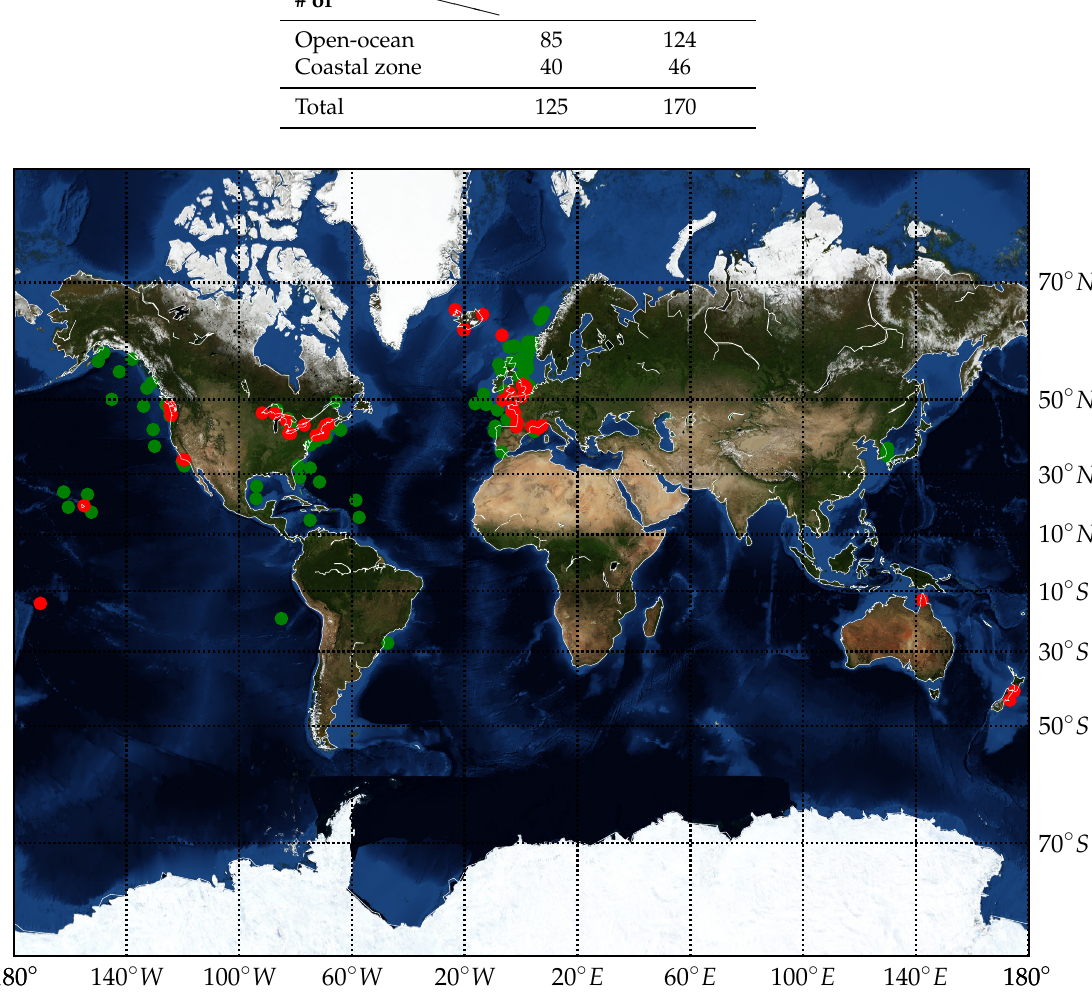
Figure 1. A distribution of the buoys used for validation of Delay-Doppler altimetry (DDA) retrackers. Coastal buoys are shown in red and open-ocean buoys are given in